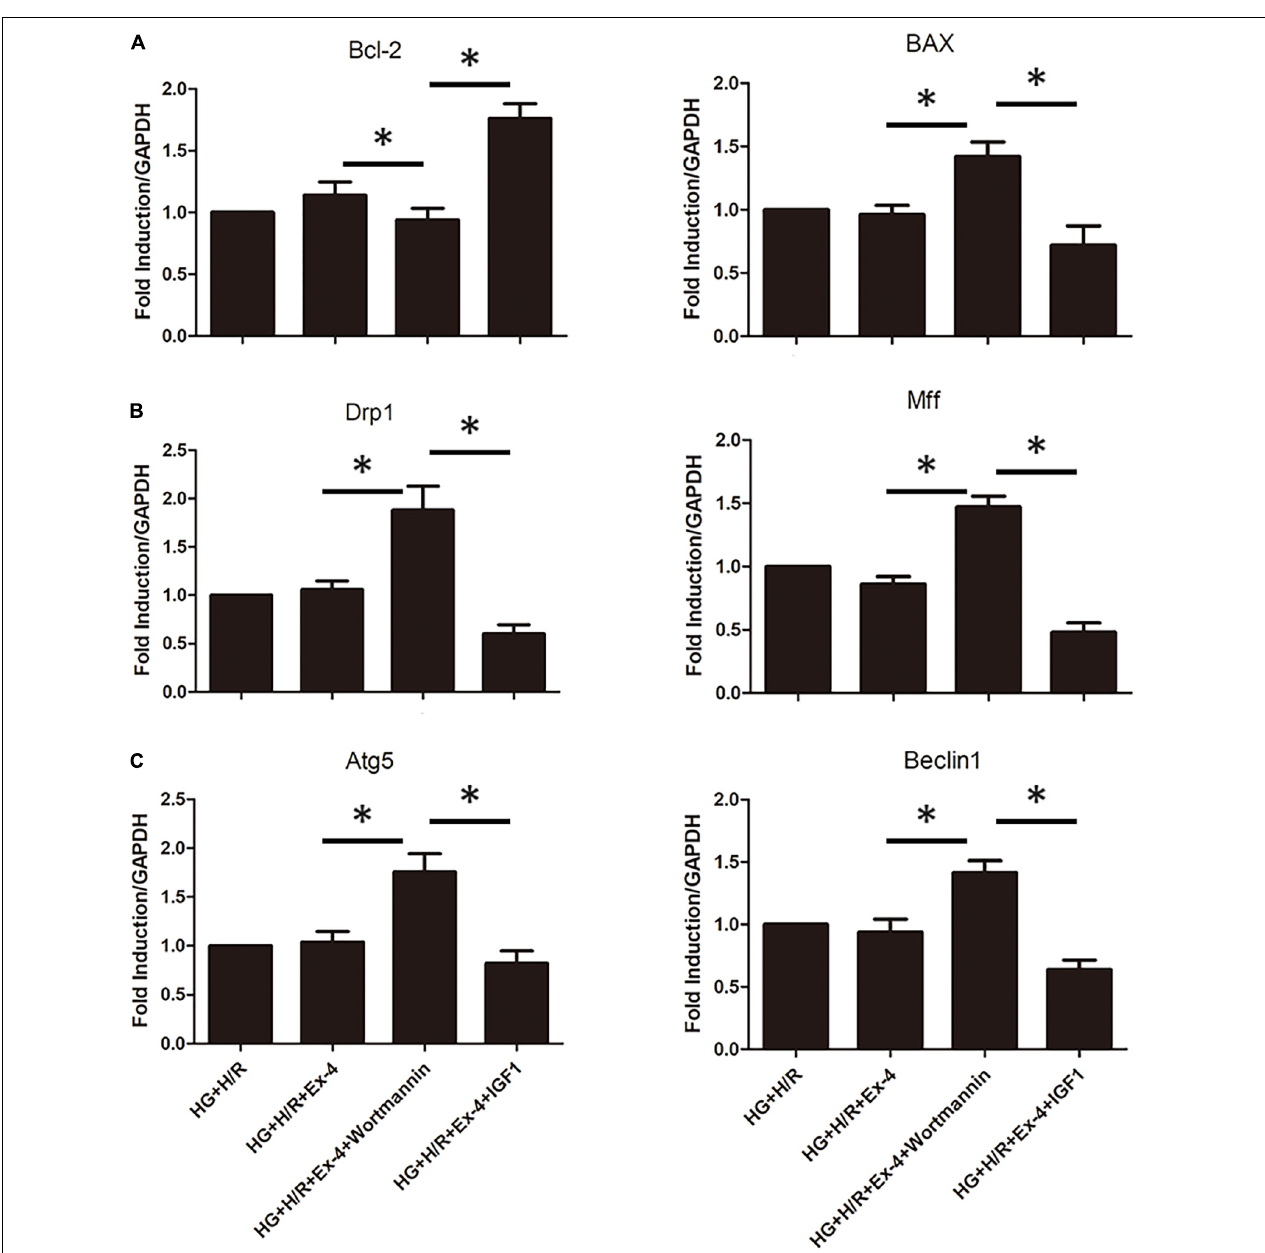
FIGURE 5 | Upregulation of β -arrestin attenuates mitochondrial dysfunction via PI3K/Akt signaling pathway. (A) qRT-PCR analysis of apoptotic biomarkers Bcl-2 and BAX. (B) qRT-PCR analysis of mitochondrial fission biomarkers Drp1 and Mff. (C) qRT-PCR analysis of mitophagy biomarkers Atg5 and Beclin1. *P < 0.05.